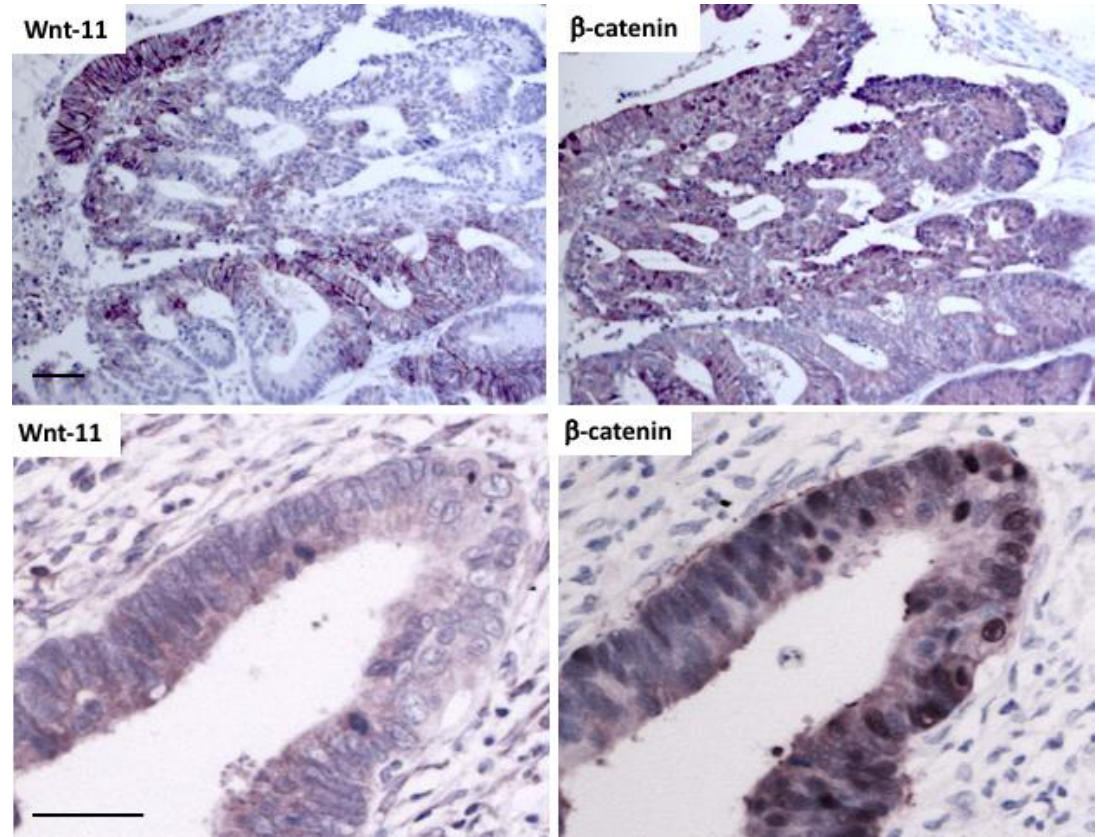
Figure 4. Comparison of Wnt-11 and β -catenin in CRC Top : immunohistochemical staining for Wnt-11 and β -catenin in adjacent sections of a CRC tumor (representative of samples from 5 patient tumors); note the lack of concordance of areas of cells with high Wnt-11 and high β -catenin. Bottom : higher magnification images of staining for Wnt-11 and β -catenin in adjacent sections of another CRC; scale bars 50 μ m.